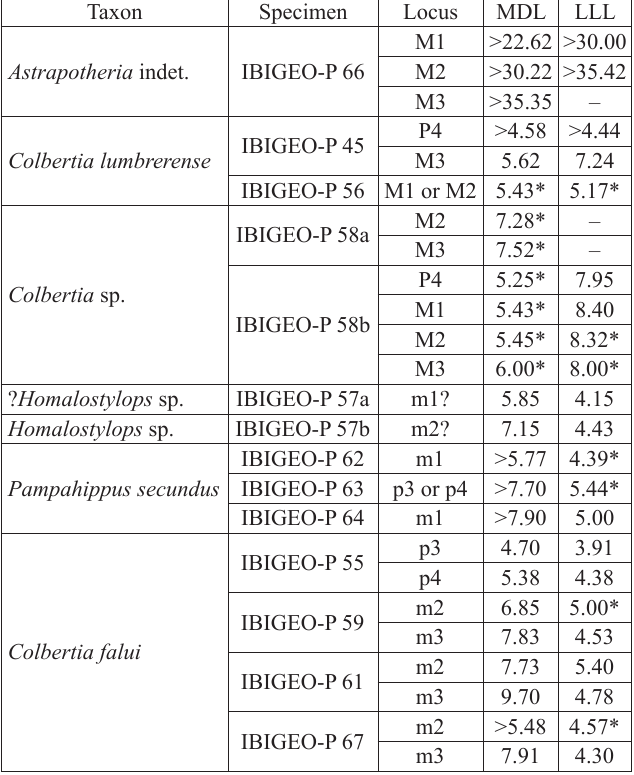
Table 1. Measurements (in mm) of the dental specimens. Abbrevia- tions: *, approximate measurements due to the brakeage of the speci- men; LLL, labio-lingual length; MDL, mesio-distal